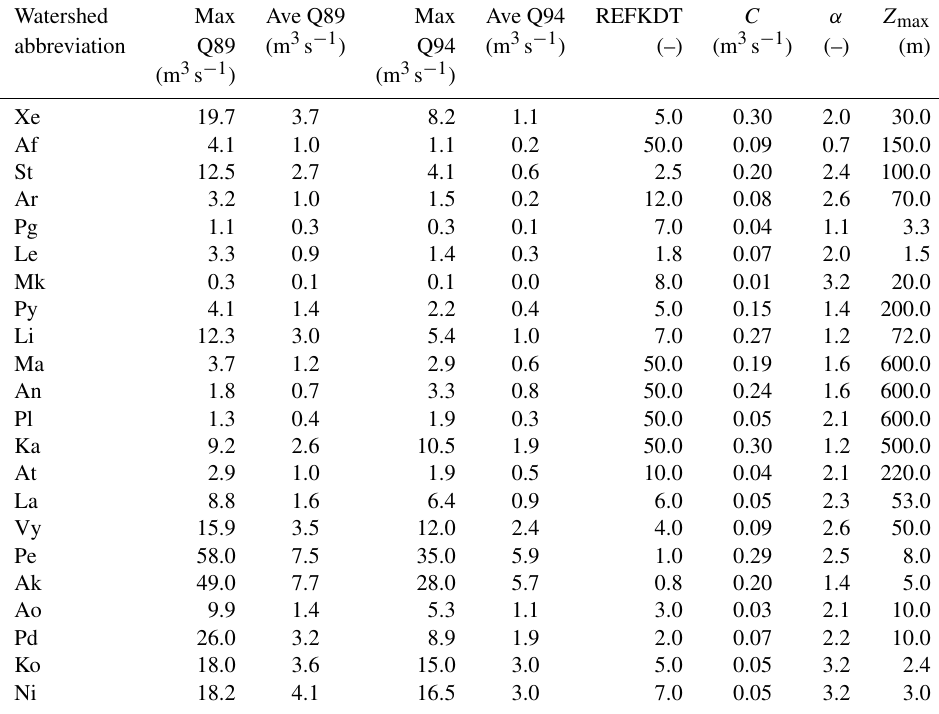
Table 4. Calibrated parameters (REFKDT, infiltration partitioning scaling coefficient; C , baseflow bucket coefficient; α , bucket exponent; Z max , maximum bucket level) for the 22 watersheds with their maximum (Max Q) and average (Ave Q) discharges for the two analysed events; for watershed abbreviations refer to Table